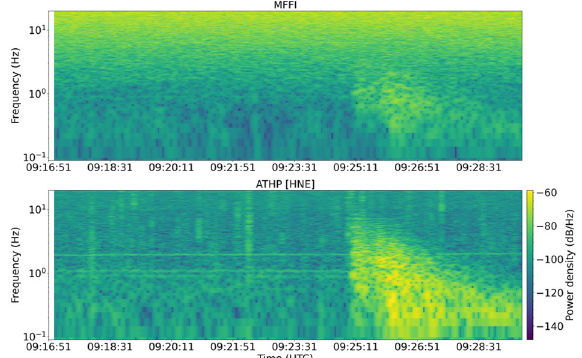
Figure 3. Spectrograms: The spectrogram generated by MFFI time-series (first derivative of strain rate) is compared to the spectrogram of the ΗΝΕ components of ATHP acceleration recordings. Similar dynamics are deduced, despite the high noise impairing MFFI spectral components above 5 Hz, attributed to low-cost solutions employed and the high noise imparing the terrestrial link.